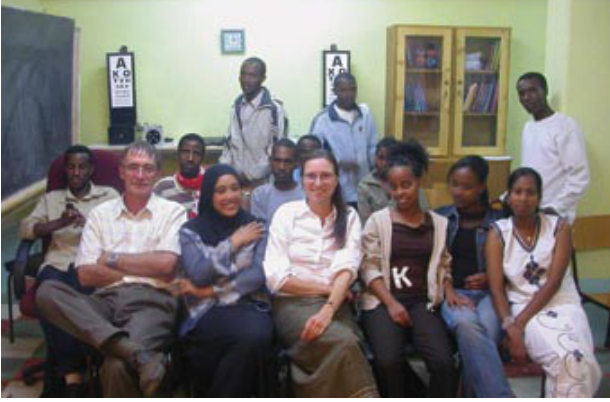
Figure 7 The class of 2008. Anthony Carlson is first left in the front row and Gemma Peters is third from the left